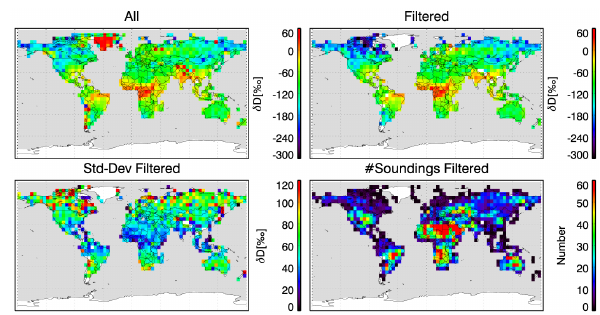
Fig. 12. Spectral fit from the TCCON site at Orleans, France, on 31 July 2010 using the spectral window of the GOSAT retrieval.